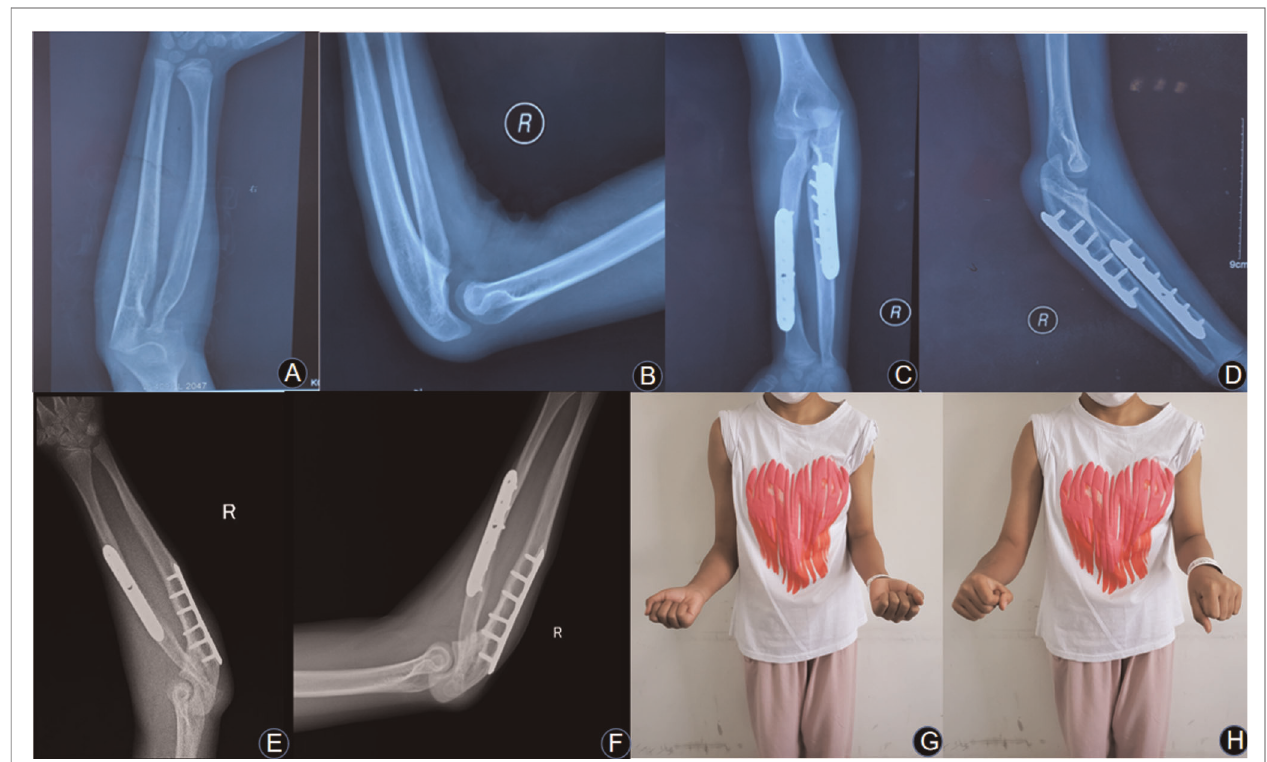
FIGURE 1 | ( A,B ) A 7-year-old girl who had right proximal radioulnar synostosis that was fi xed in the pronation position. Her preoperative Failla score was 8 points. Preoperative anteroposterior and lateral views of the right proximal radioulnar synostosis show a Cleary and Omer type III deformity. ( C,D ) Bone union was achieved at the osteotomy site after 3 months of surgery. ( E,F ) Excellent bone result is shown on anteroposterior and lateral views of X-ray at 7 years after the operation. ( G,H ) The rotational function of the right forearm was signi fi cantly improved at the last visit. The patient ’ s daily activities were greatly